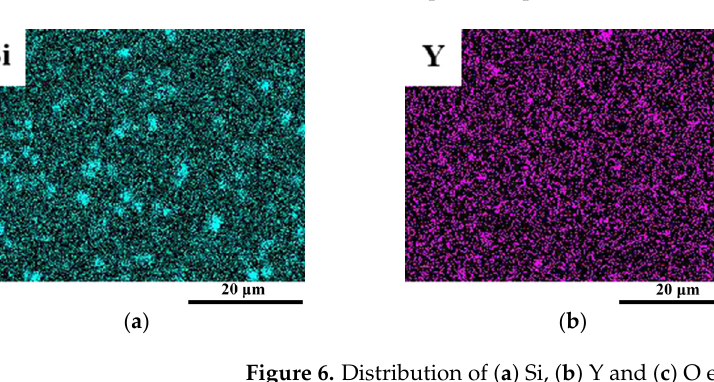
Figure 5. Electron probe maps of ( a ) 1280-S1, ( b ) 1280-S2 and ( c ) 1280-S3 ODS steels.